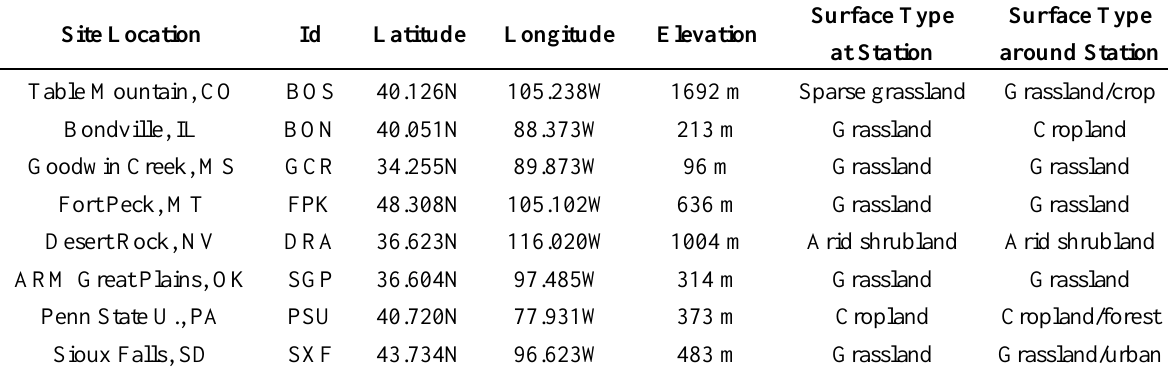
Table 1. List of Surface Radiation (SURFRAD) sites including geo-location, elevation, and basic description of the surface type at station location and around the station within Geostationary Operational Environmental Satellite (GOES) footprints.